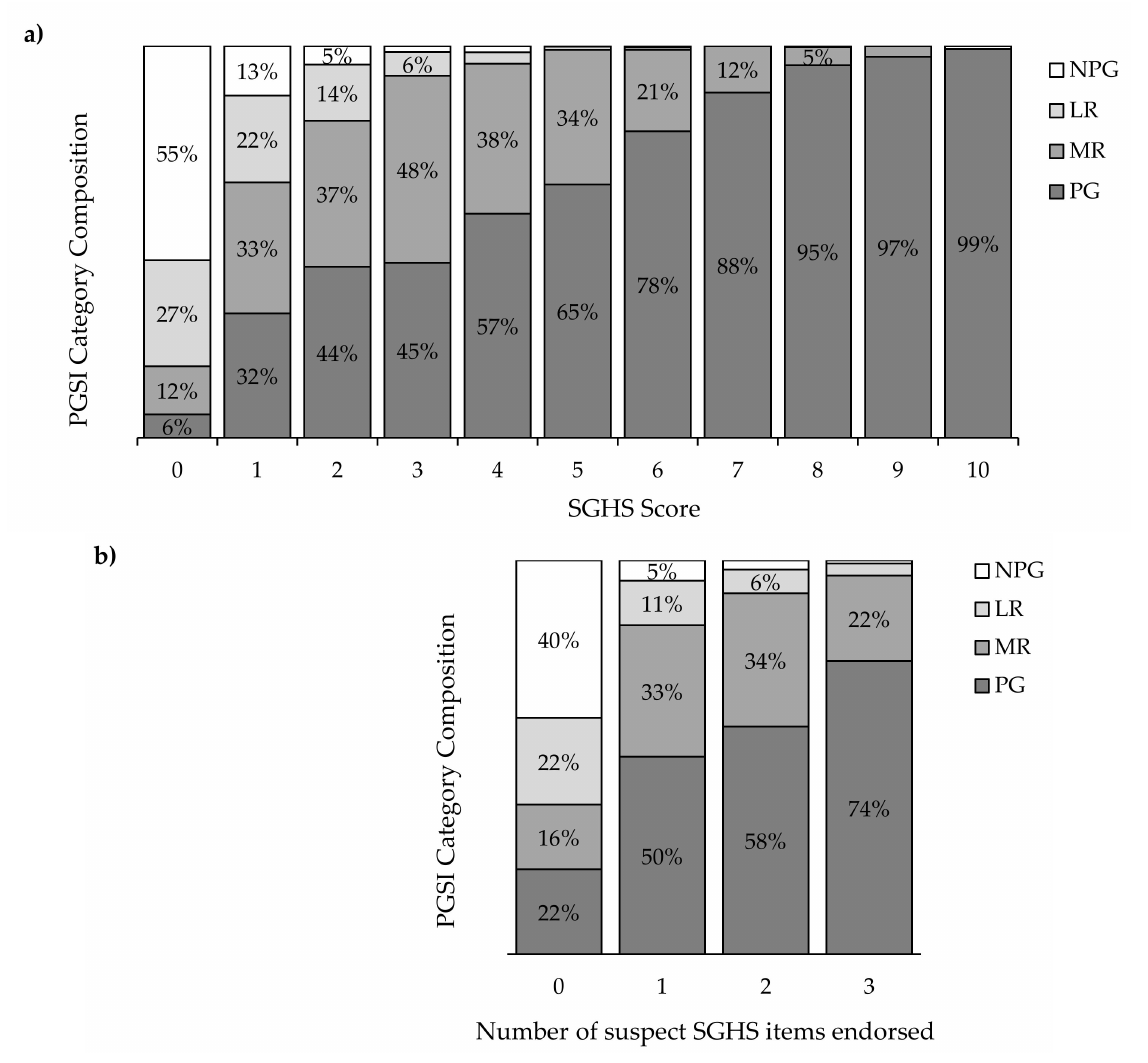
Figure 2. Breakdown of PGSI category among gamblers by: ( a ) SGHS score (top), ( b ) number of “milder” SGHS items endorsed